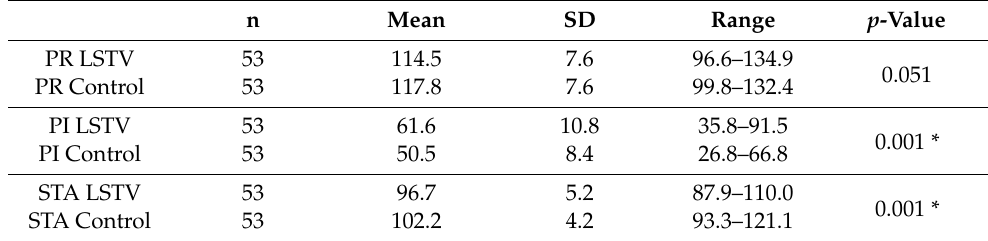
Table 2. Comparison between the LSTV ( n = 53) and the matched control group ( n = 53) in terms of PI (pelvic incidence), PR (pelvic radius), and STA (sacral table angle) (SD: standard deviation). For the 6 LV patients, we have considered the measurement point S2 (true S1) in the calculation. Significance level was assessed at p < 0.05, with * indicating a significant difference.